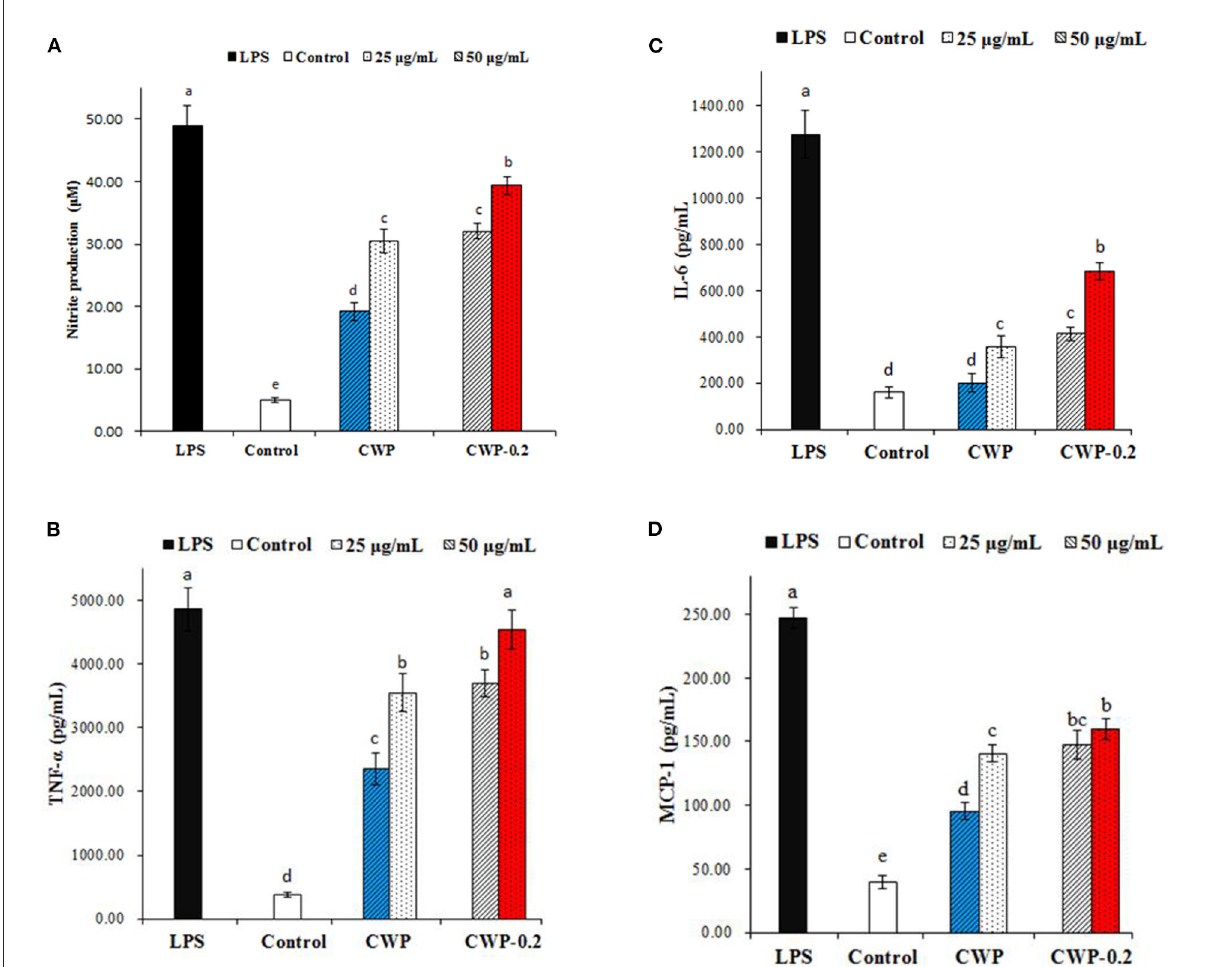
FIGURE4 Effects of polysaccharides CWP and CWP-0.2 on RAW 264.7 macrophage (A) NO, (B) TNF- α , (C) IL-6, and (D) MCP-1 production. Values are the mean ± SD ( n = 3). The different small letters in different columns represent significant difference at 0.05